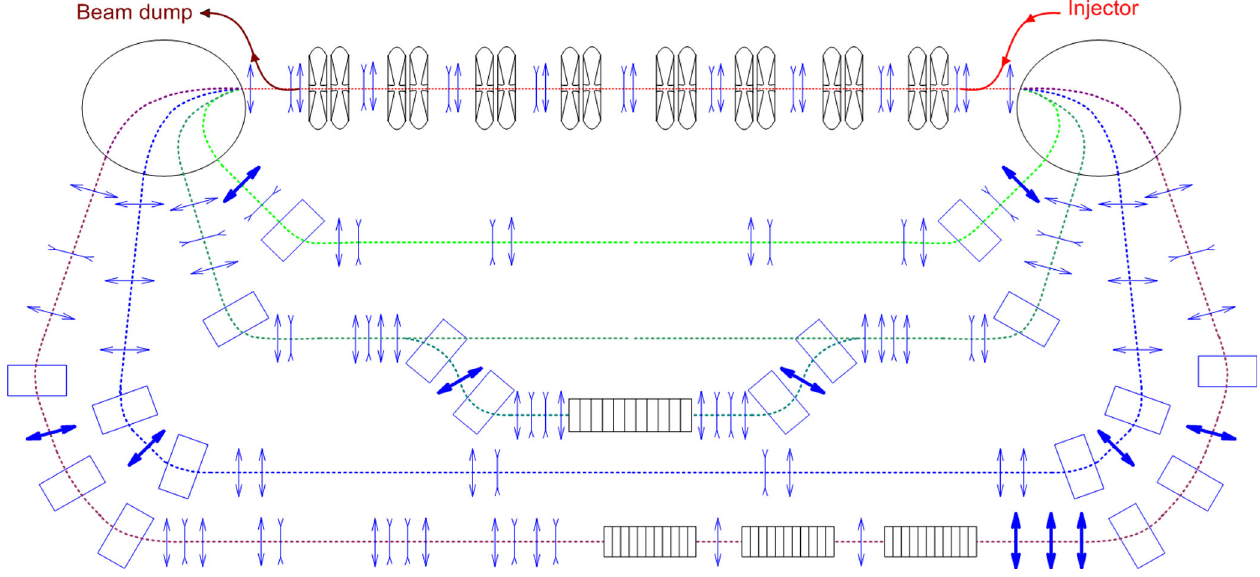
FIG. 1. Arrangement of new undulator in bypass of second track of